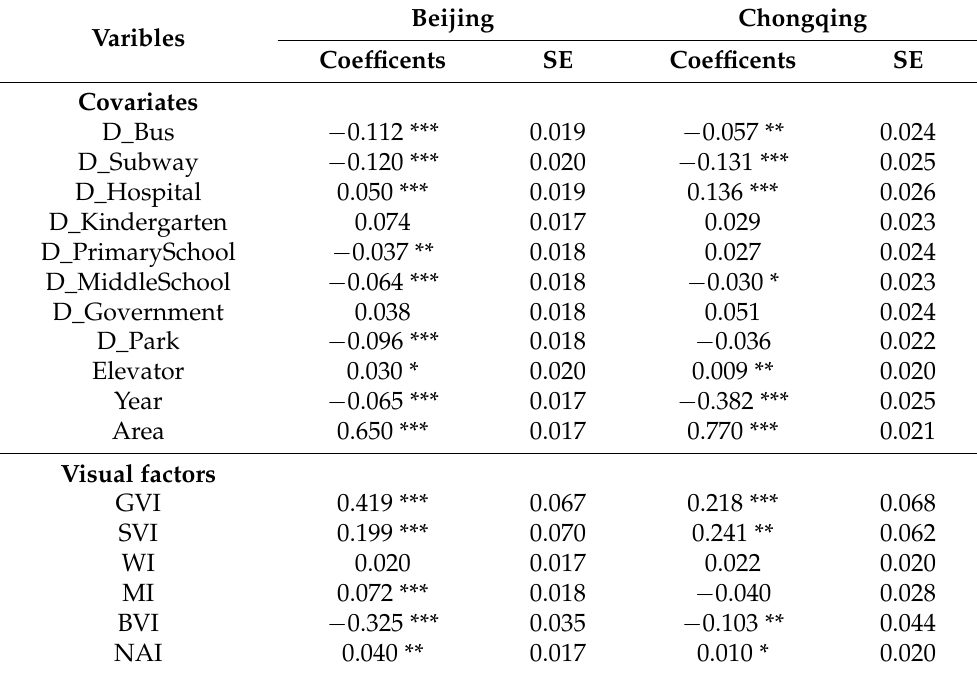
Table 6. Results of the global regression